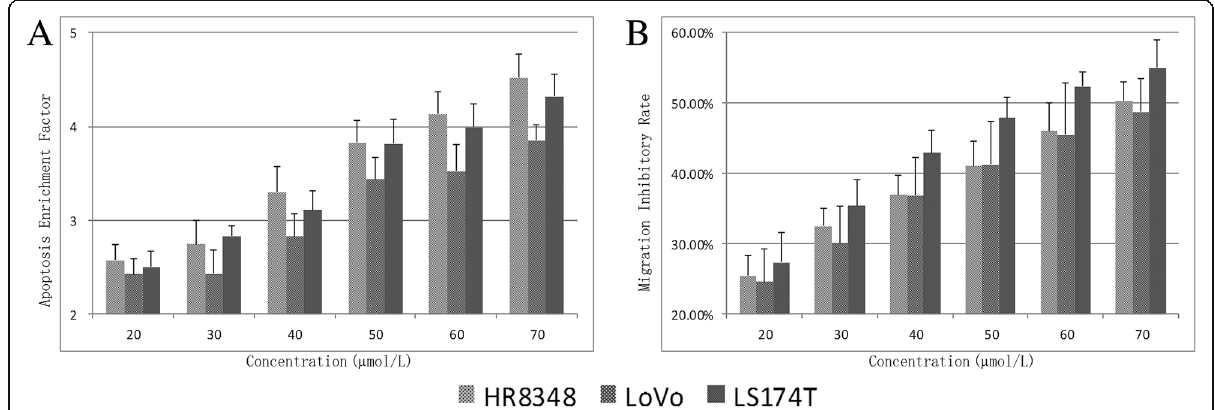
Fig. 3 Effects of chebulinic acid on cell apoptosis and migration in HR8348, LoVo, and LS174T cells. a Determination of apoptosis by a DNA fragmentation immunoassay. The enrichment factor was used as an index of apoptosis, which represents the level of DNA fragmentation in cells treated with chebulinic acid relative to that in untreated cells. b Examination of cell migration capacity through a Boyden chamber assay. The number of